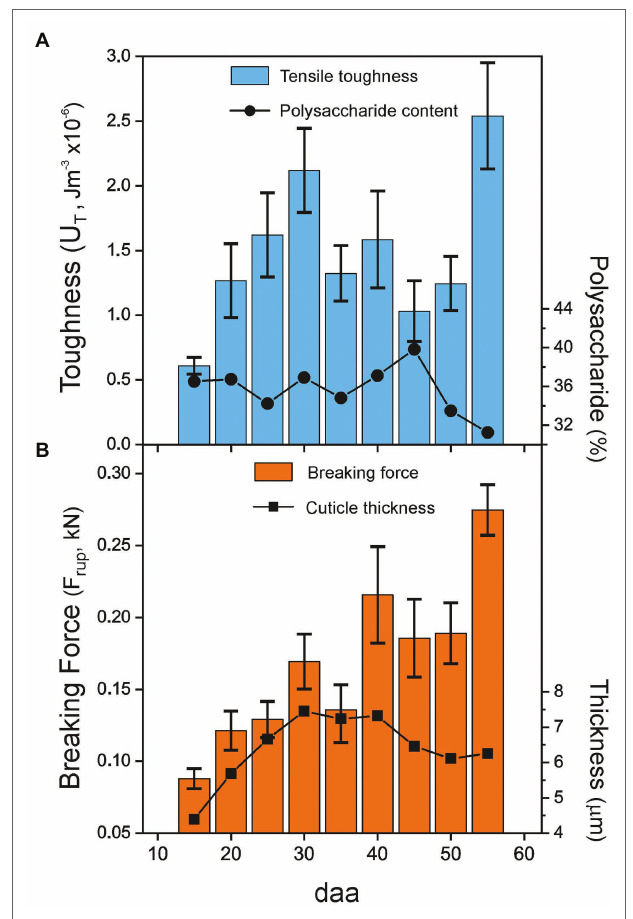
FIGURE 5 | (A) Toughness (U T ) and (B) net breaking force (F rup ) of tomato Cascada cuticles vs. fruit development. For reference, the polysaccharide content (circles) and the cuticle thickness (t L ; squares) values are included in the plots. Percentage of cuticle polysaccharides and cuticle thickness taken from Domínguez et al.